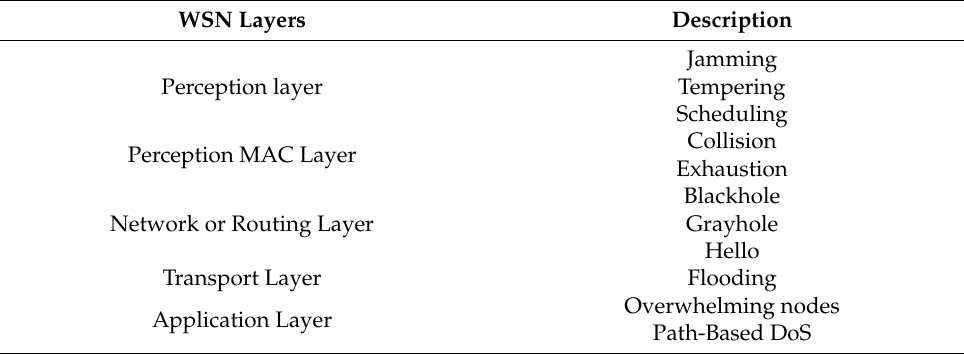
Table 1. Taxonomy of WSN DDoS